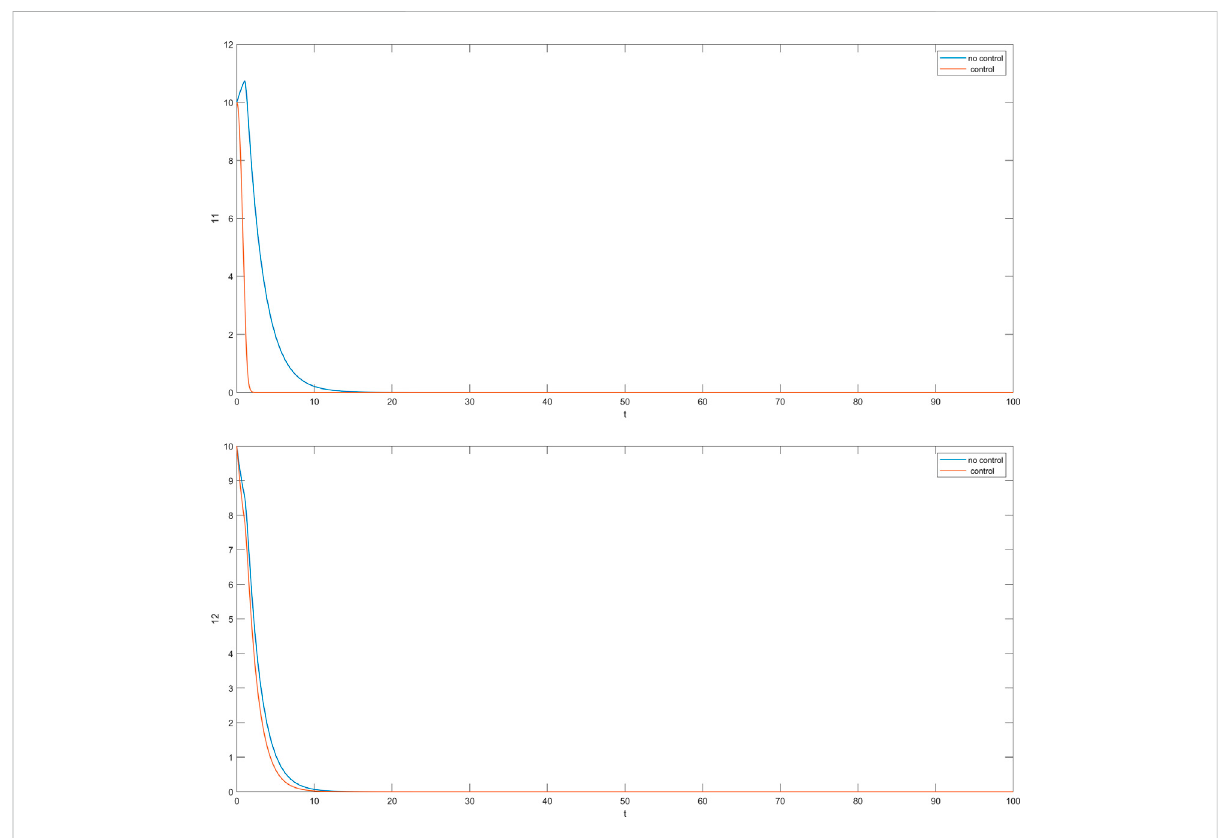
FIGURE 7 Comparison of trends of I 1 and I 2 with and without